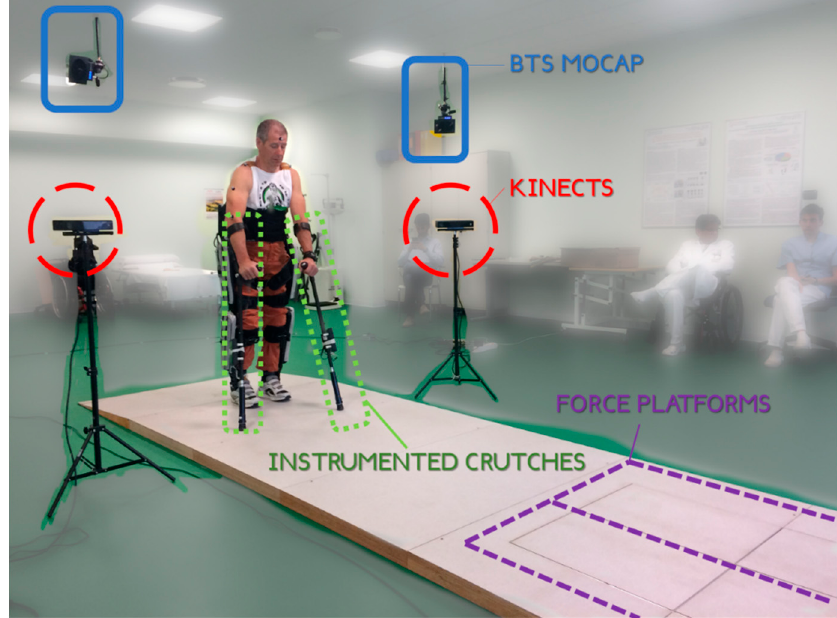
Figure 4. The gait lab used to perform the validation. The instrumentation used is highlighted.